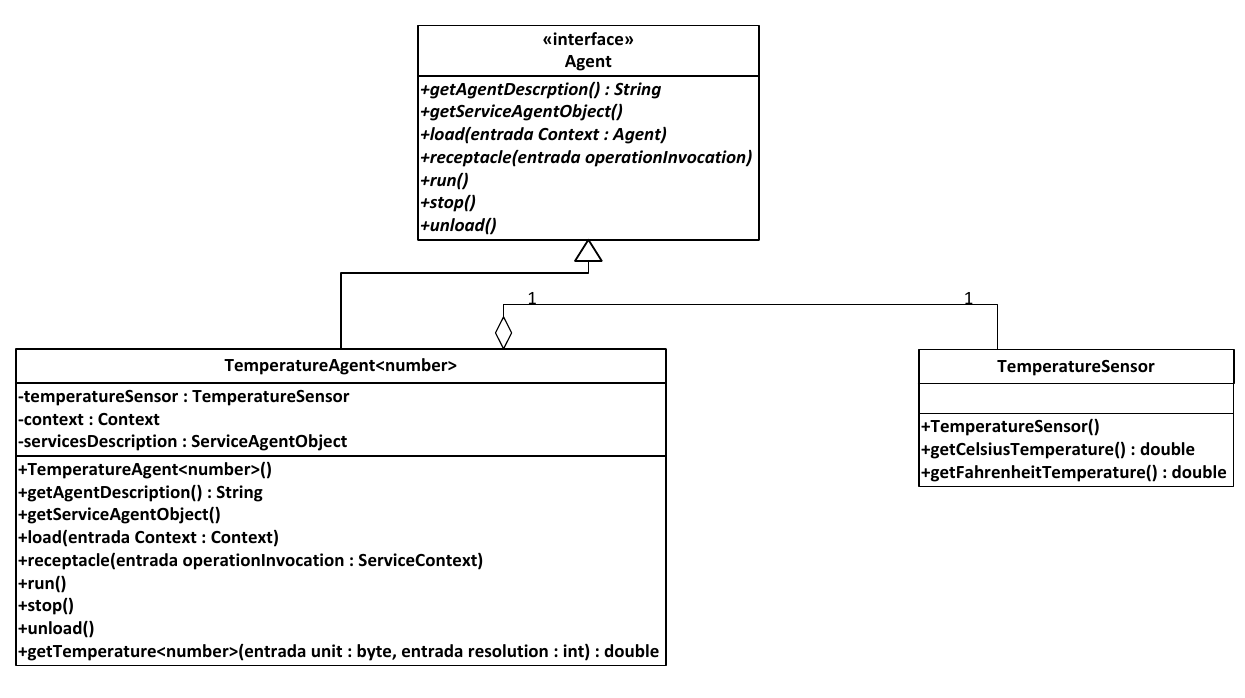
Figure 17. Class diagram of the temperature agents.